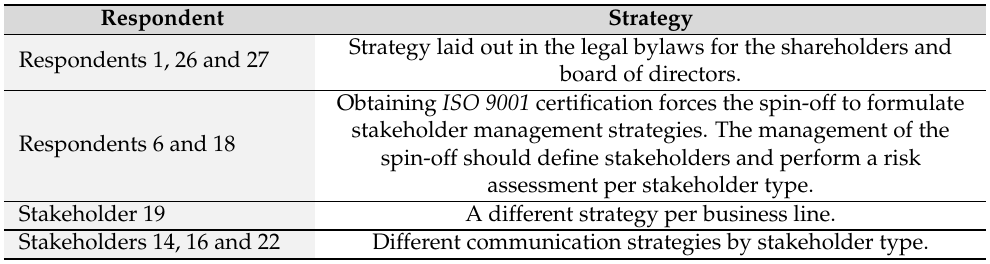
Table 10. Stakeholder management strategies used by USO